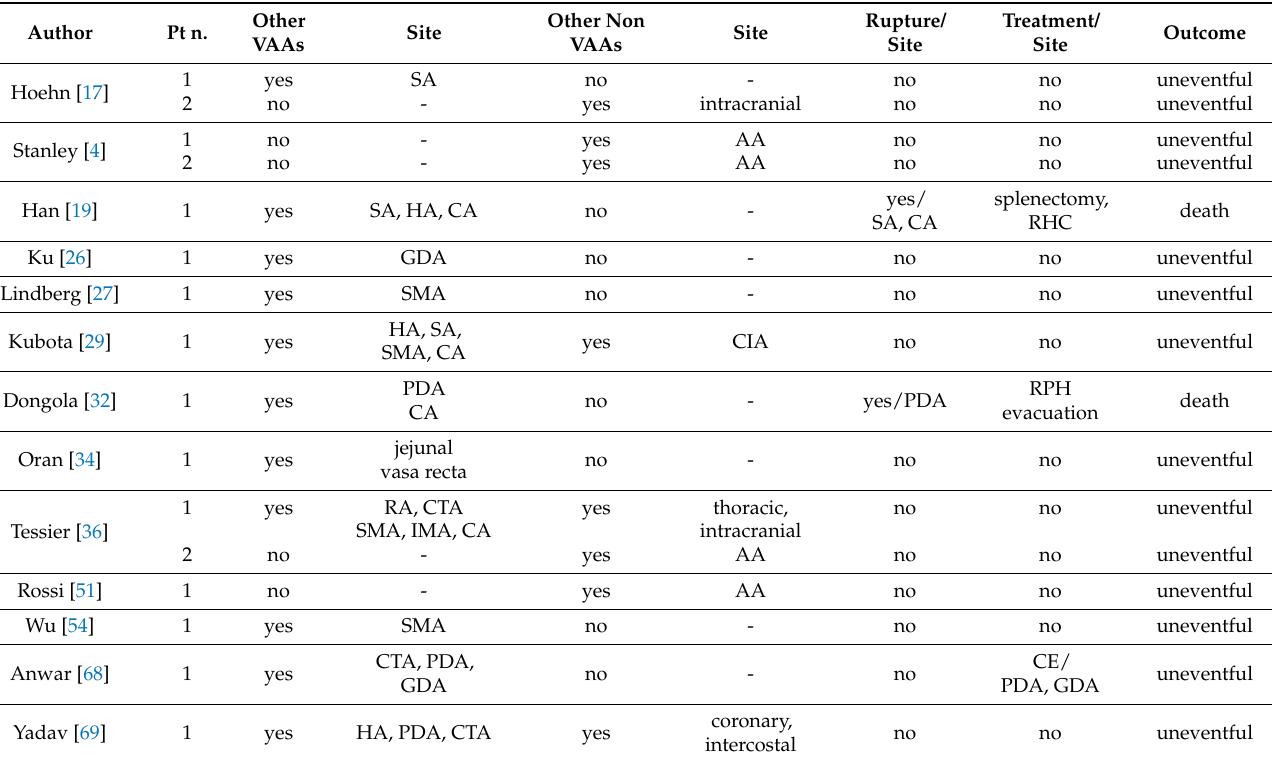
Table 4. Concomitant aneurysms identified in our literature review.